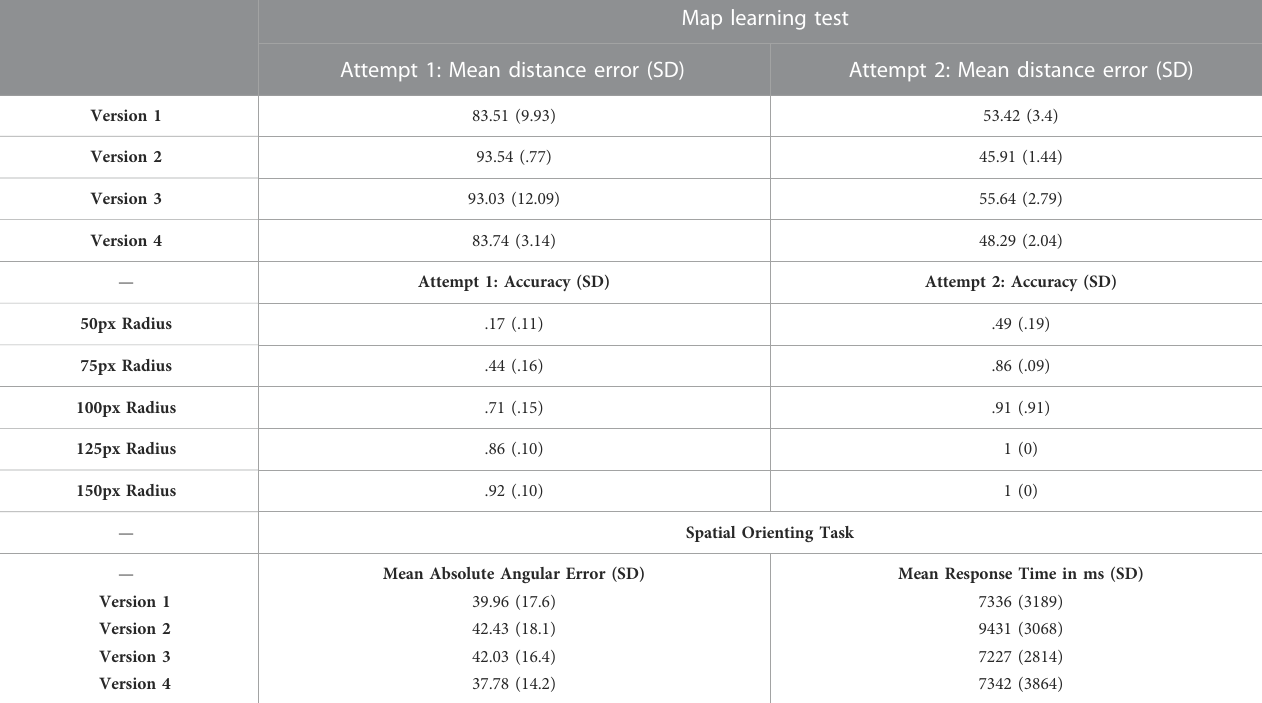
TABLE 2 Upper: Mean, standard deviation (SD), and minimum and maximum distance error (in pixels) for the map learning criterial learning test (for fi rst and second learning attempts), reported separately for each of the four task versions. Middle: Mean and standard deviation accuracy level by distance criterion (in pixels), for the two learning attempts on the map learning pilot test, separated by the four task versions. Lower: Mean absolute angular error and response times (with standard deviation) during the spatial orienting task, separated by the four task